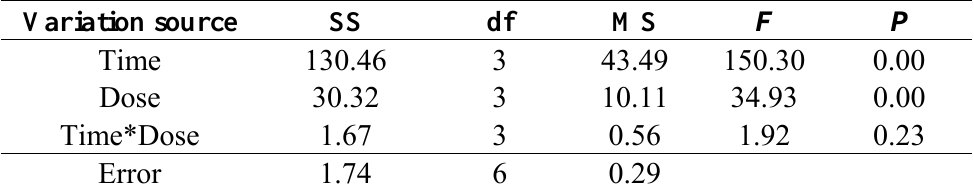
Table 3. ANOVA of cerebral infraction volume.